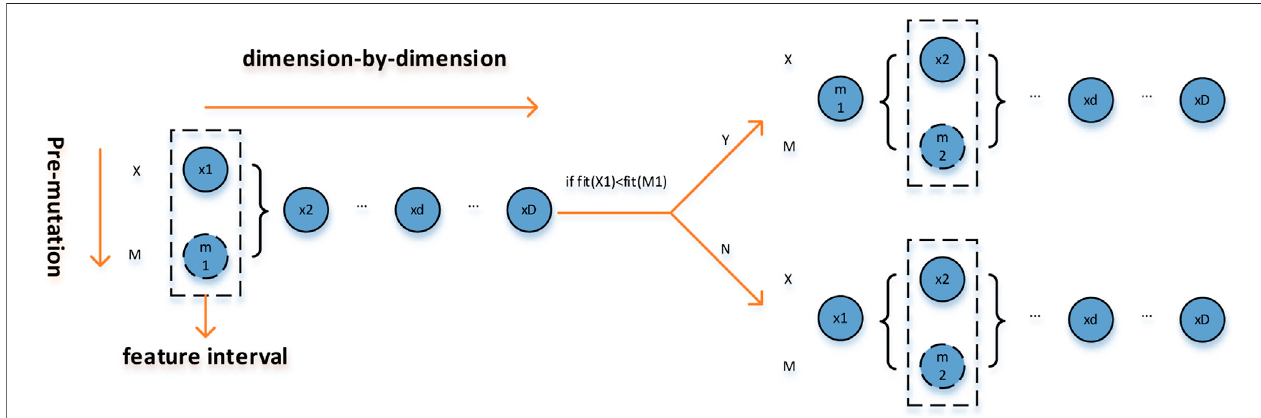
FIGURE 1 | Diagram of dimension-by-dimension mutation based on feature